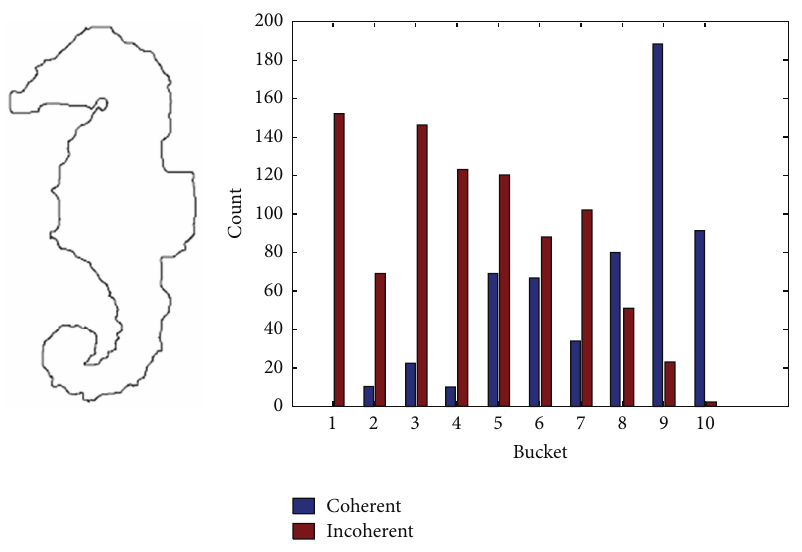
Figure 2: Hippocampus image in the SQUID and its corresponding DCV